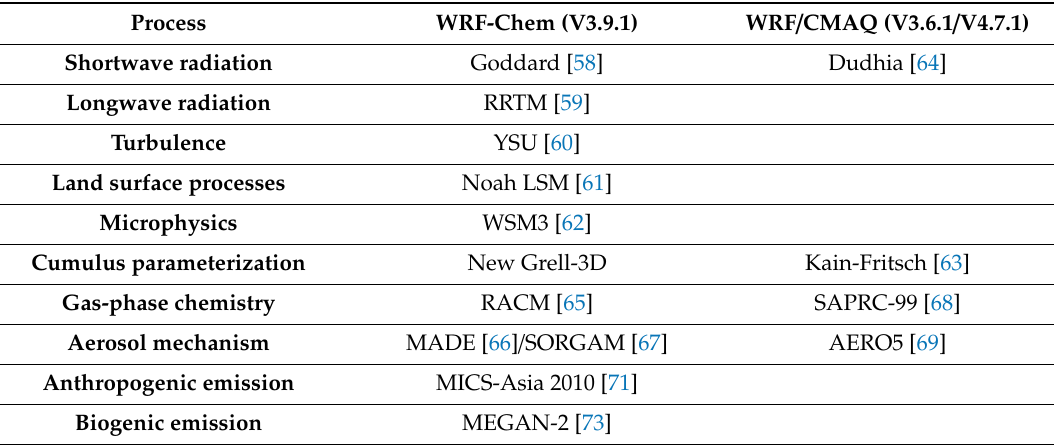
The configuration of the physical and chemical processes in the WRF-Chem and WRF / CMAQ